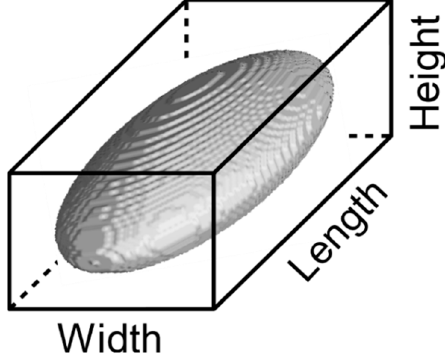
Figure 3. Sketched dimensions for a simulated ellipsoid.